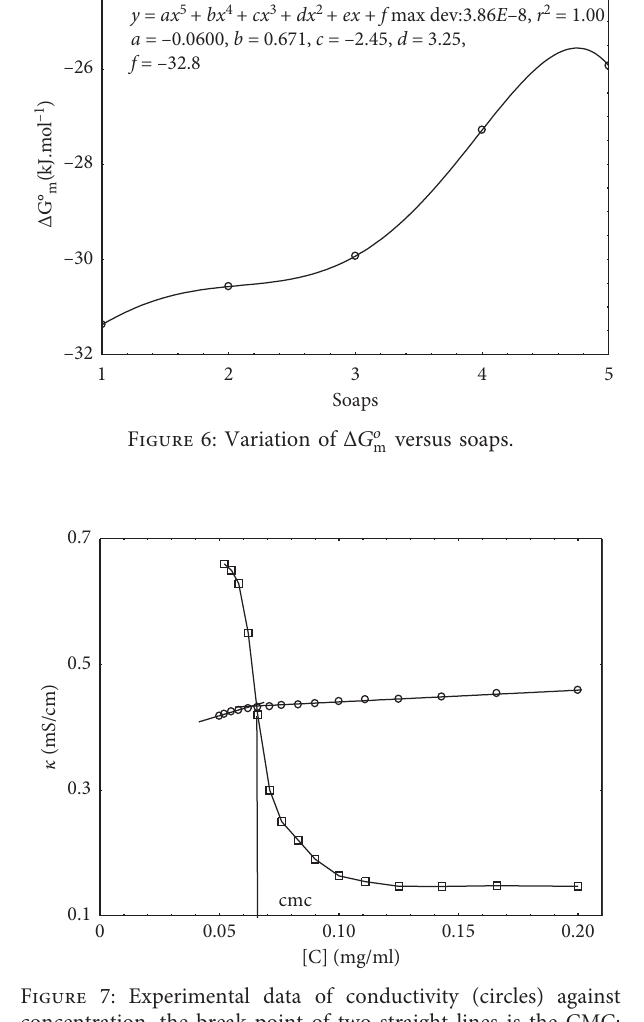
Figure 7: Experimental data of conductivity (circles) against concentration, the break point of two straight lines is the CMC; K ( c ) , and their corresponding first derivative (squares), κ ( c ) , for LFBY at 303.15K. The lines are the best fits of data.